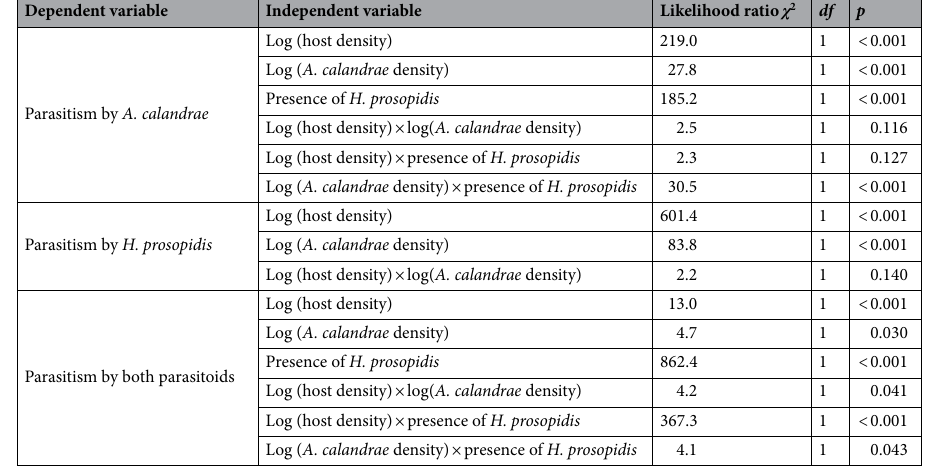
Table 3. Effect tests for the logistic regression model of parasitism as a function of host density, the density of the native parasitoid Anisopteromalus calandrae , the presence/absence of the nonnative parasitoid Heterospilus prosopidis , and all two-way